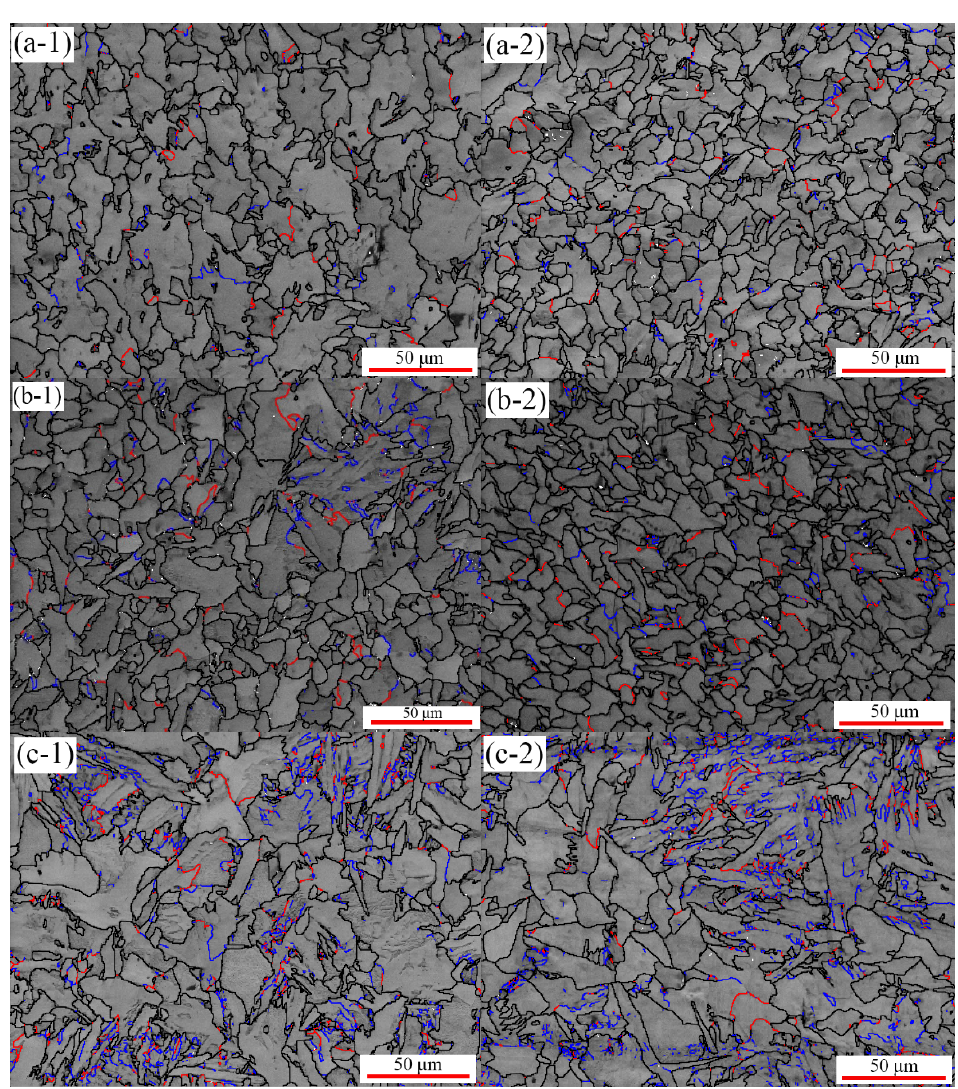
Figure 3. EBSD band contrast maps with grain boundary misorientation distribution of Q235 (blue: BRA < 5°; red: 5° < BRA < 15°, black: 15° < BRA). ( a-1 – c-1 ) are cooled samples at 25 K/min and ( a-2 – c-2 ) are cooled samples at 50 K/min. Red and blue lines indicate the low-angle boundaries, black lines indicate high-angle boundaries, respectively.